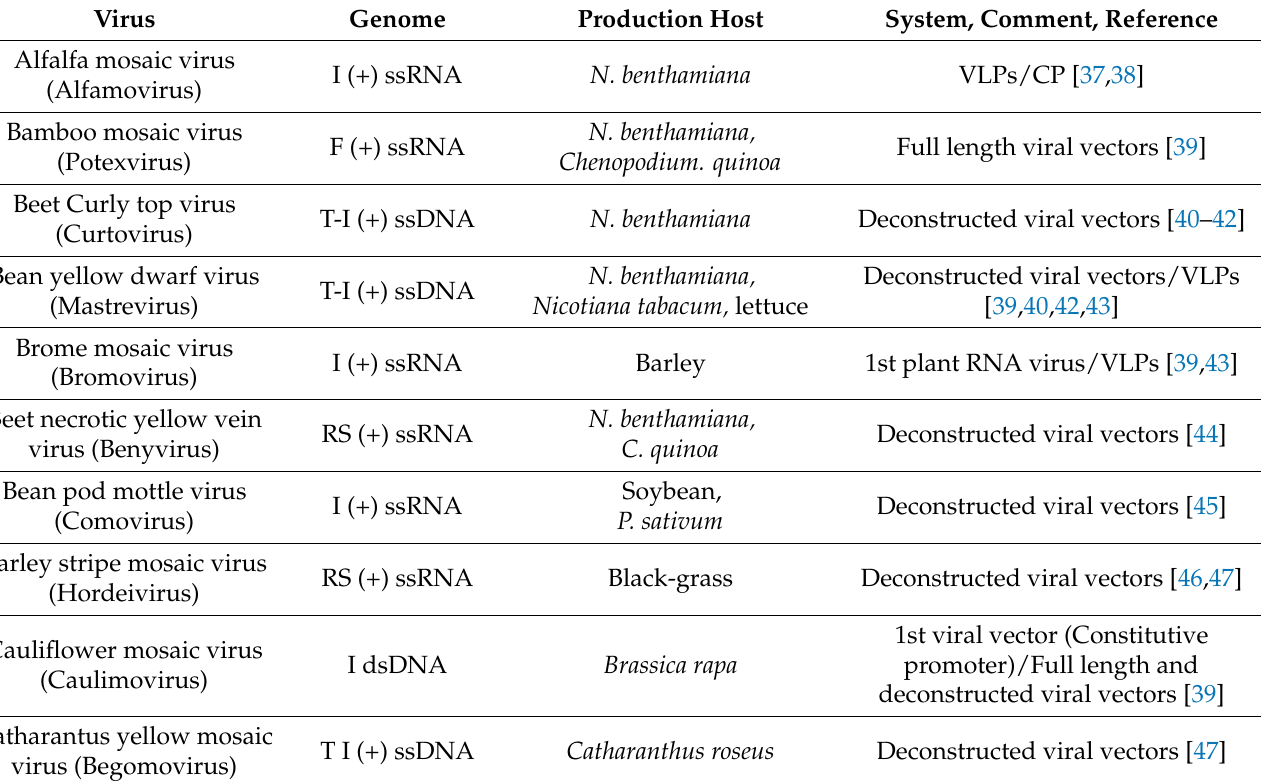
Table 1. Example of plant viruses used as viral expression vectors and their selected applications. Virus Genome Production Host System, Comment,